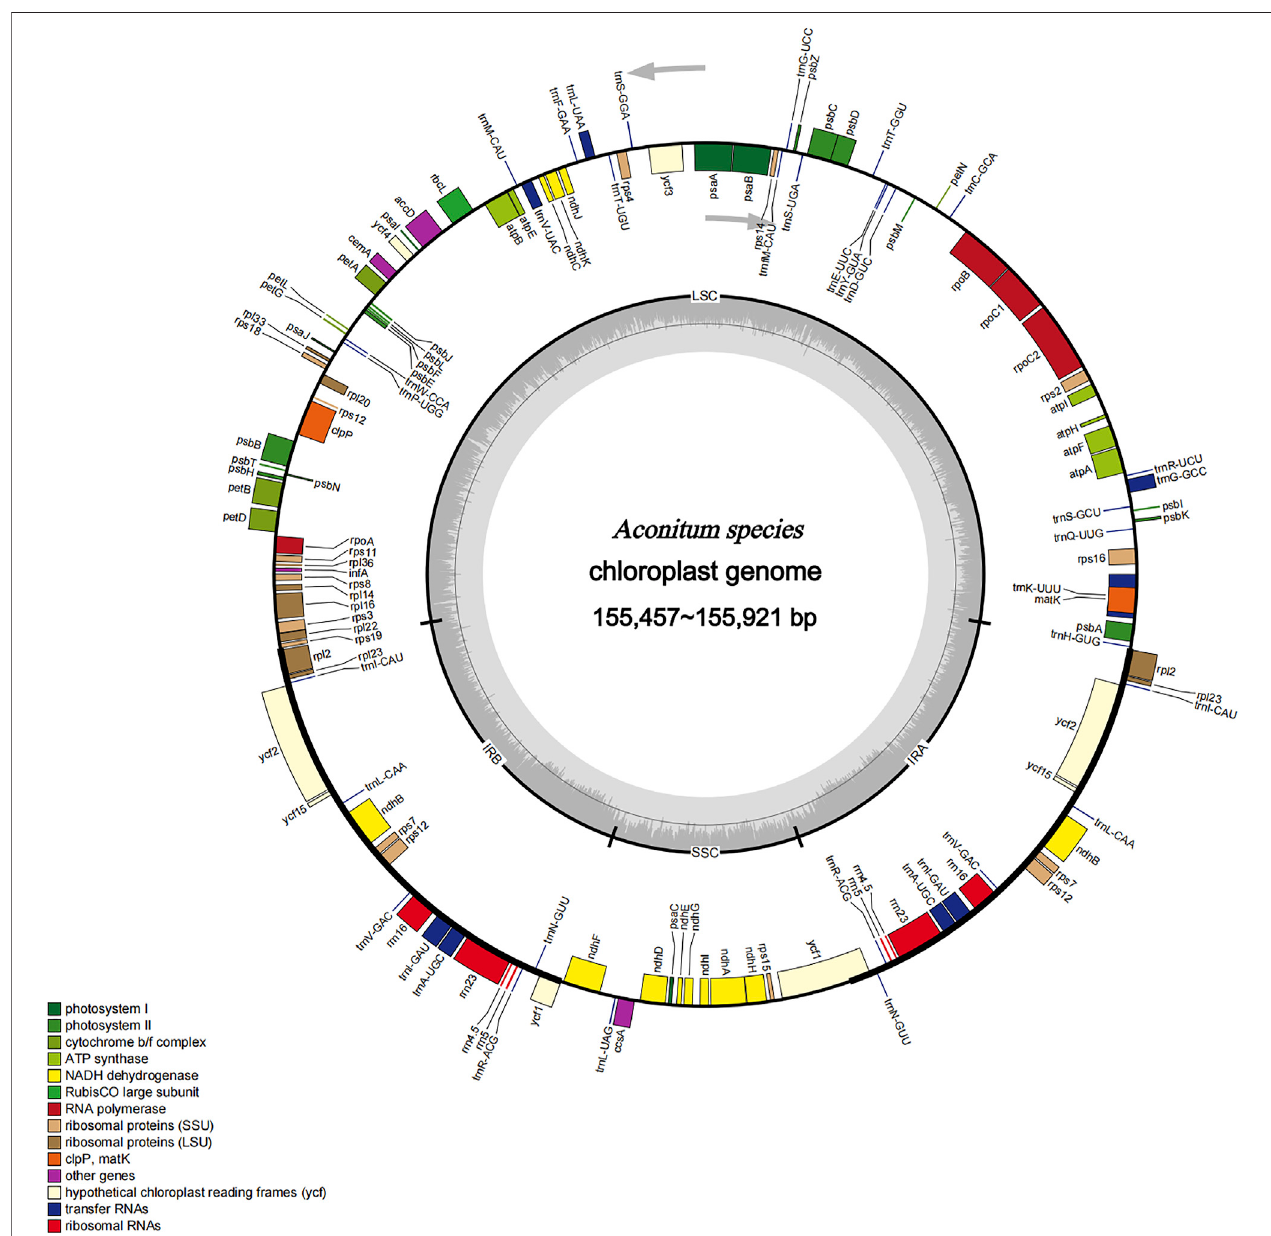
FIGURE 2 | Gene map of the complete chloroplast genomes of Aconitum species. Genes inside the circle are transcribed clockwise, and those on the outside are transcribed counter-clockwise. Genes belonging to different functional groups have been colour-coded. The darker grey area in the inner circle corresponds to GC content, whereas the lighter grey corresponds to AT